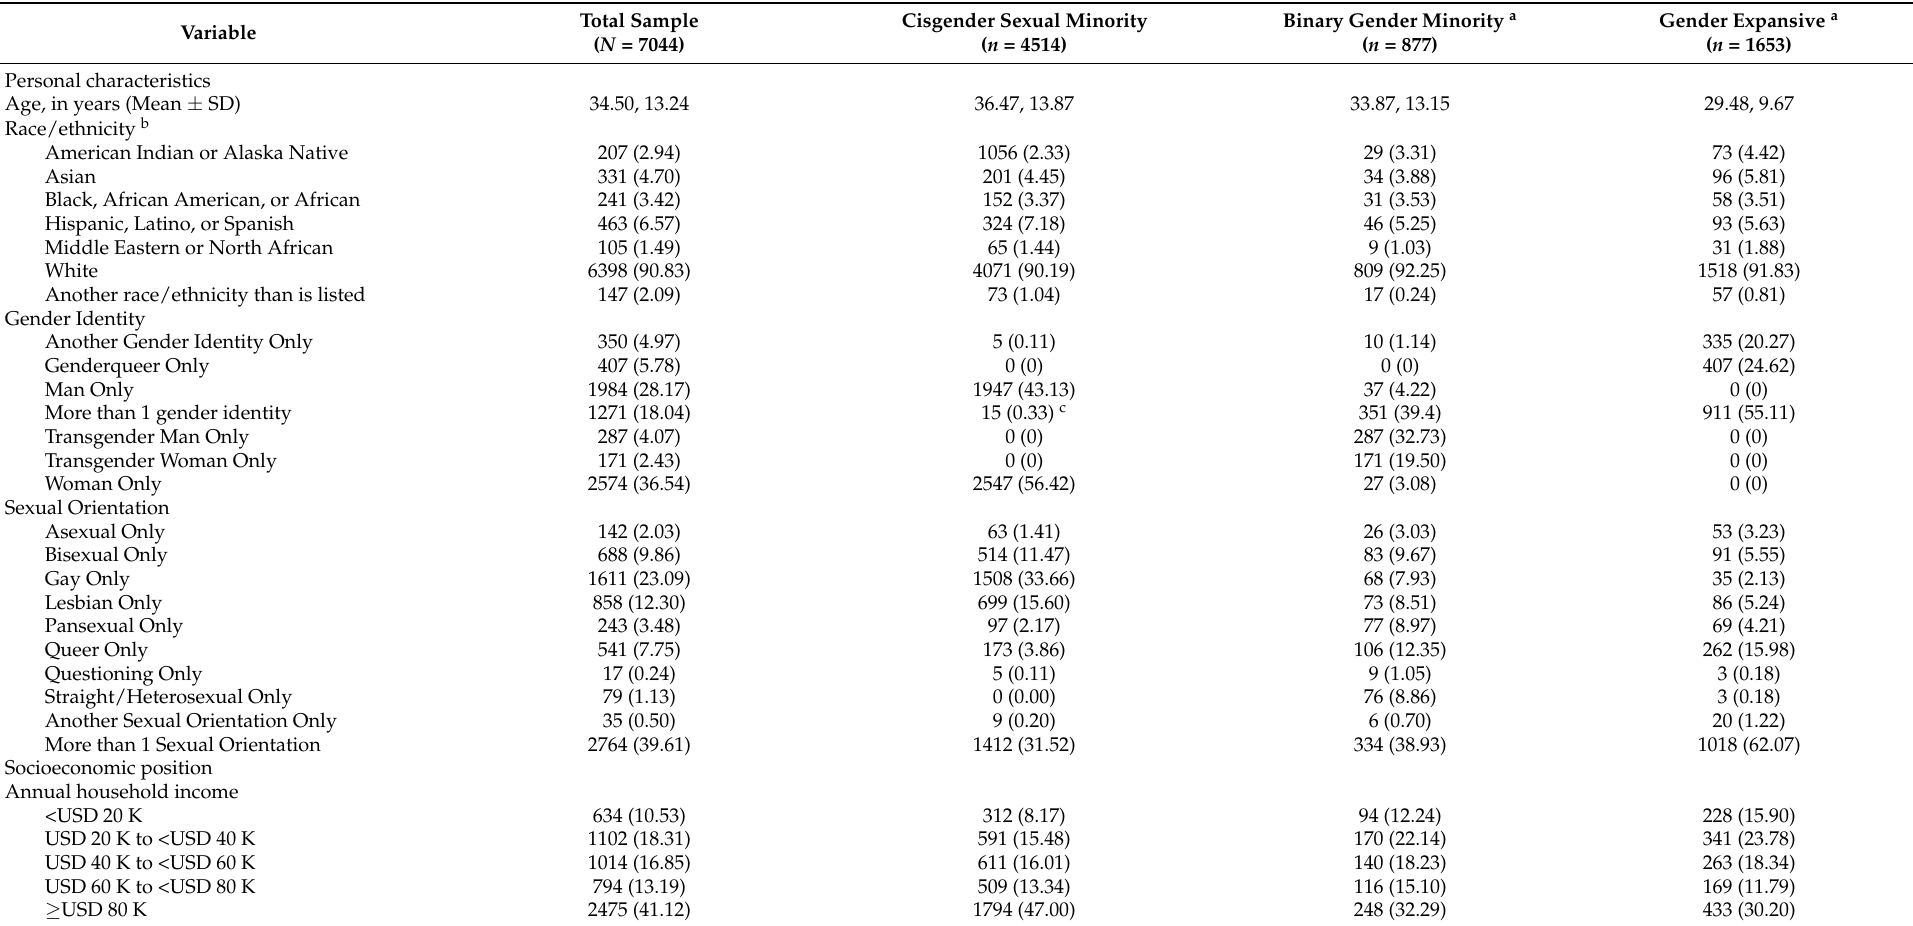
Table 1. Characteristics of The PRIDE Study 2018 Annual Questionnaire Participants ( N =